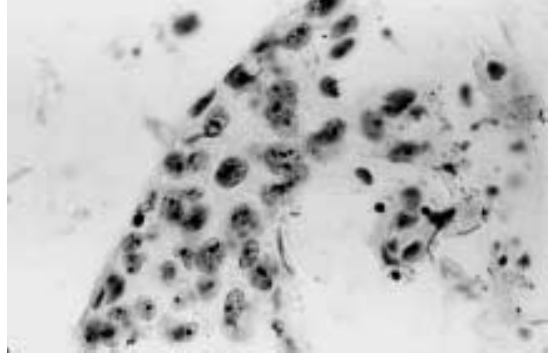
Fig. 1. Normal superficial squamous epithelial cells. Silver stained for AgNOR-analysis. Only few NORs are visible within nucleoli. 100 × objective.